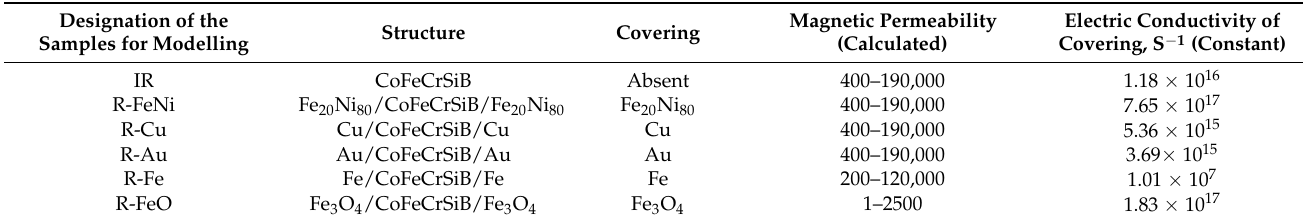
Table 1. Designation of the models (samples) of the CoFeCrSiB ribbons with various coatings with thickness 1 μ m and some properties of coatings.